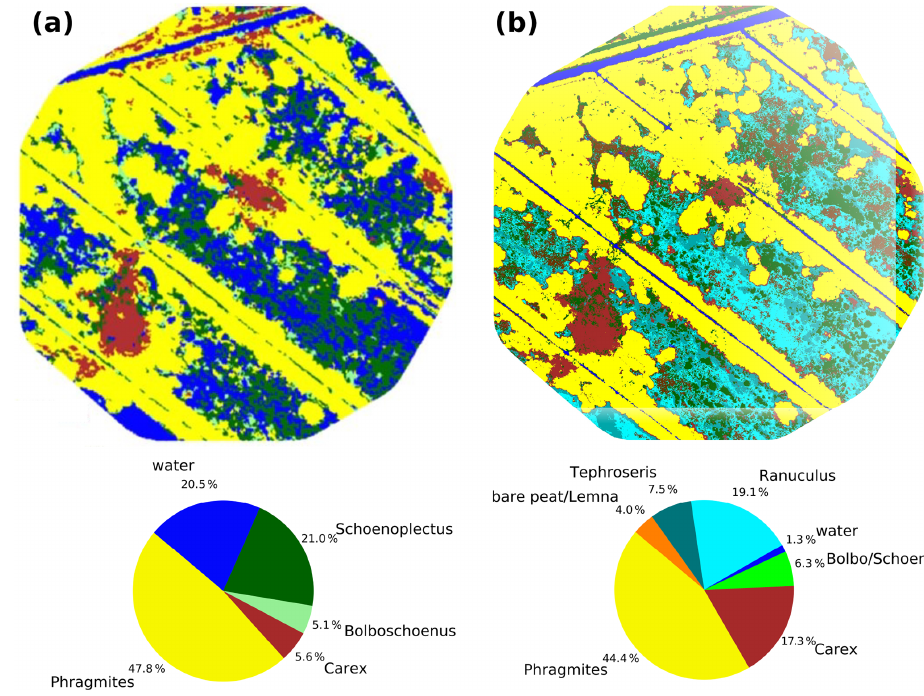
Figure 4. Vegetation composition in 2014 (a) as presented in Koch et al. (2017) and after the drought in 2018 (b) .